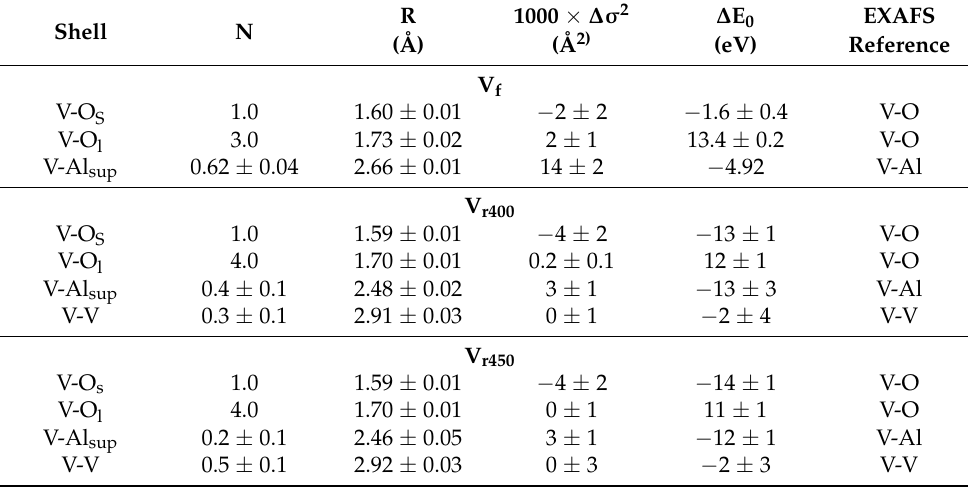
Table 4. Summary of EXAFS analysis results for V f , V r400 , and V r450 .